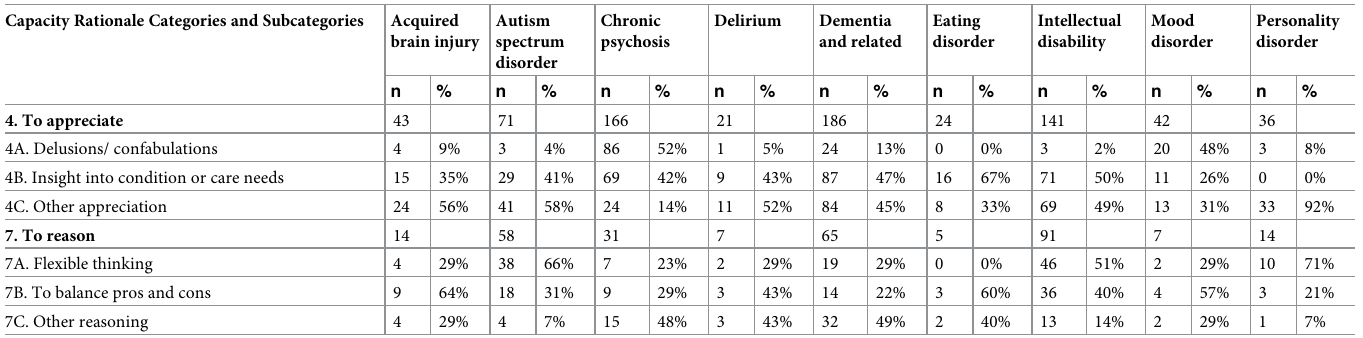
Table 5. Frequency of capacity rationales according to impairment of mind or brain (diagnosis)—subcategories of appreciation and reasoning 1, 2, 3 . Capacity Rationale Categories and